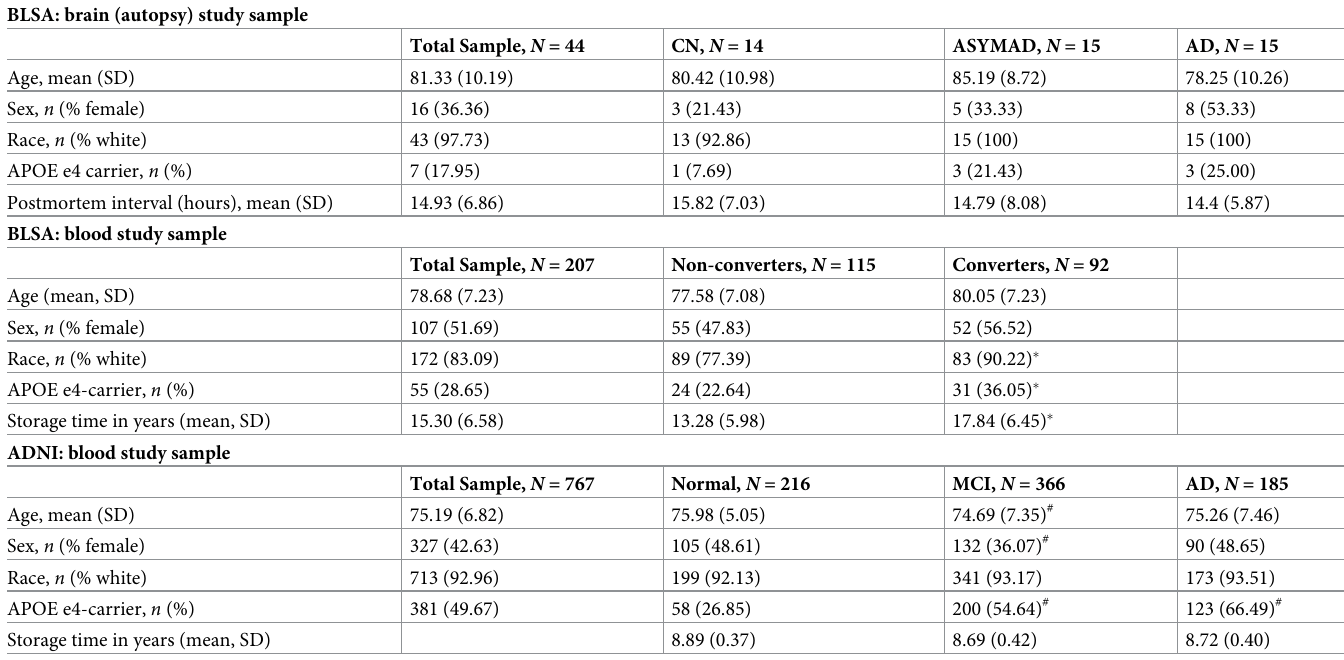
Table 1. Demographic characteristics of study samples. BLSA: brain (autopsy) study